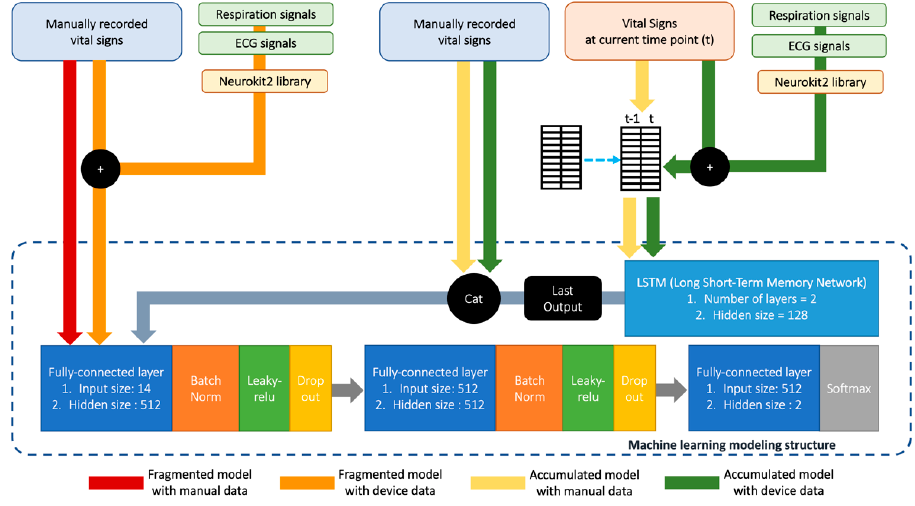
Figure 1. Technical structure of the prediction modelling process.